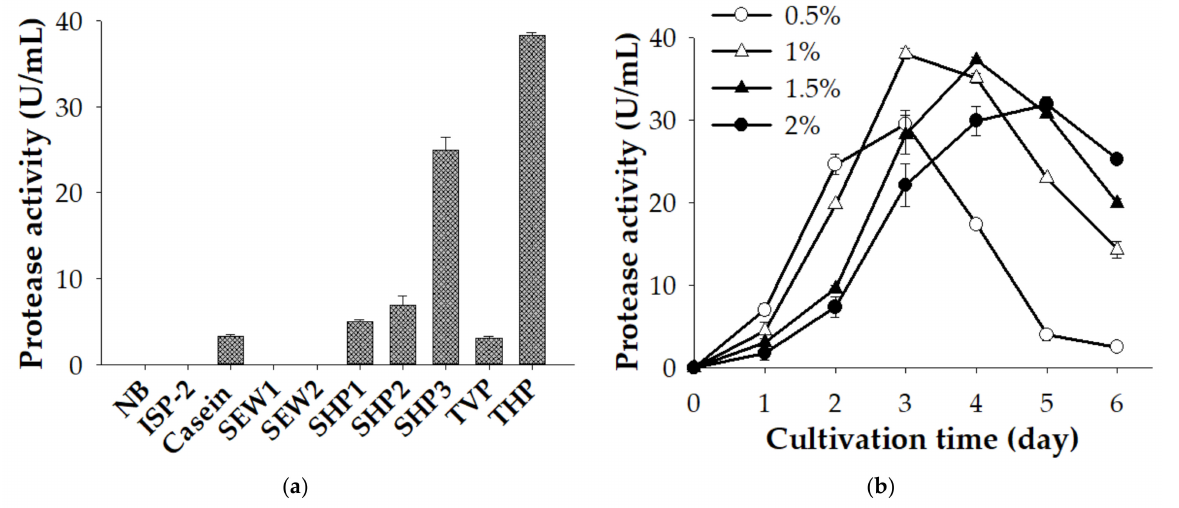
Figure 1. Effect of the C/N nutrient ( a ) and tuna head powder (THP) amount ( b ) on the protease productivity of Streptomyces speibonae TKU048. All data points are means ± S.D. (standard deviation) of three different experiments (each experiment was conducted in